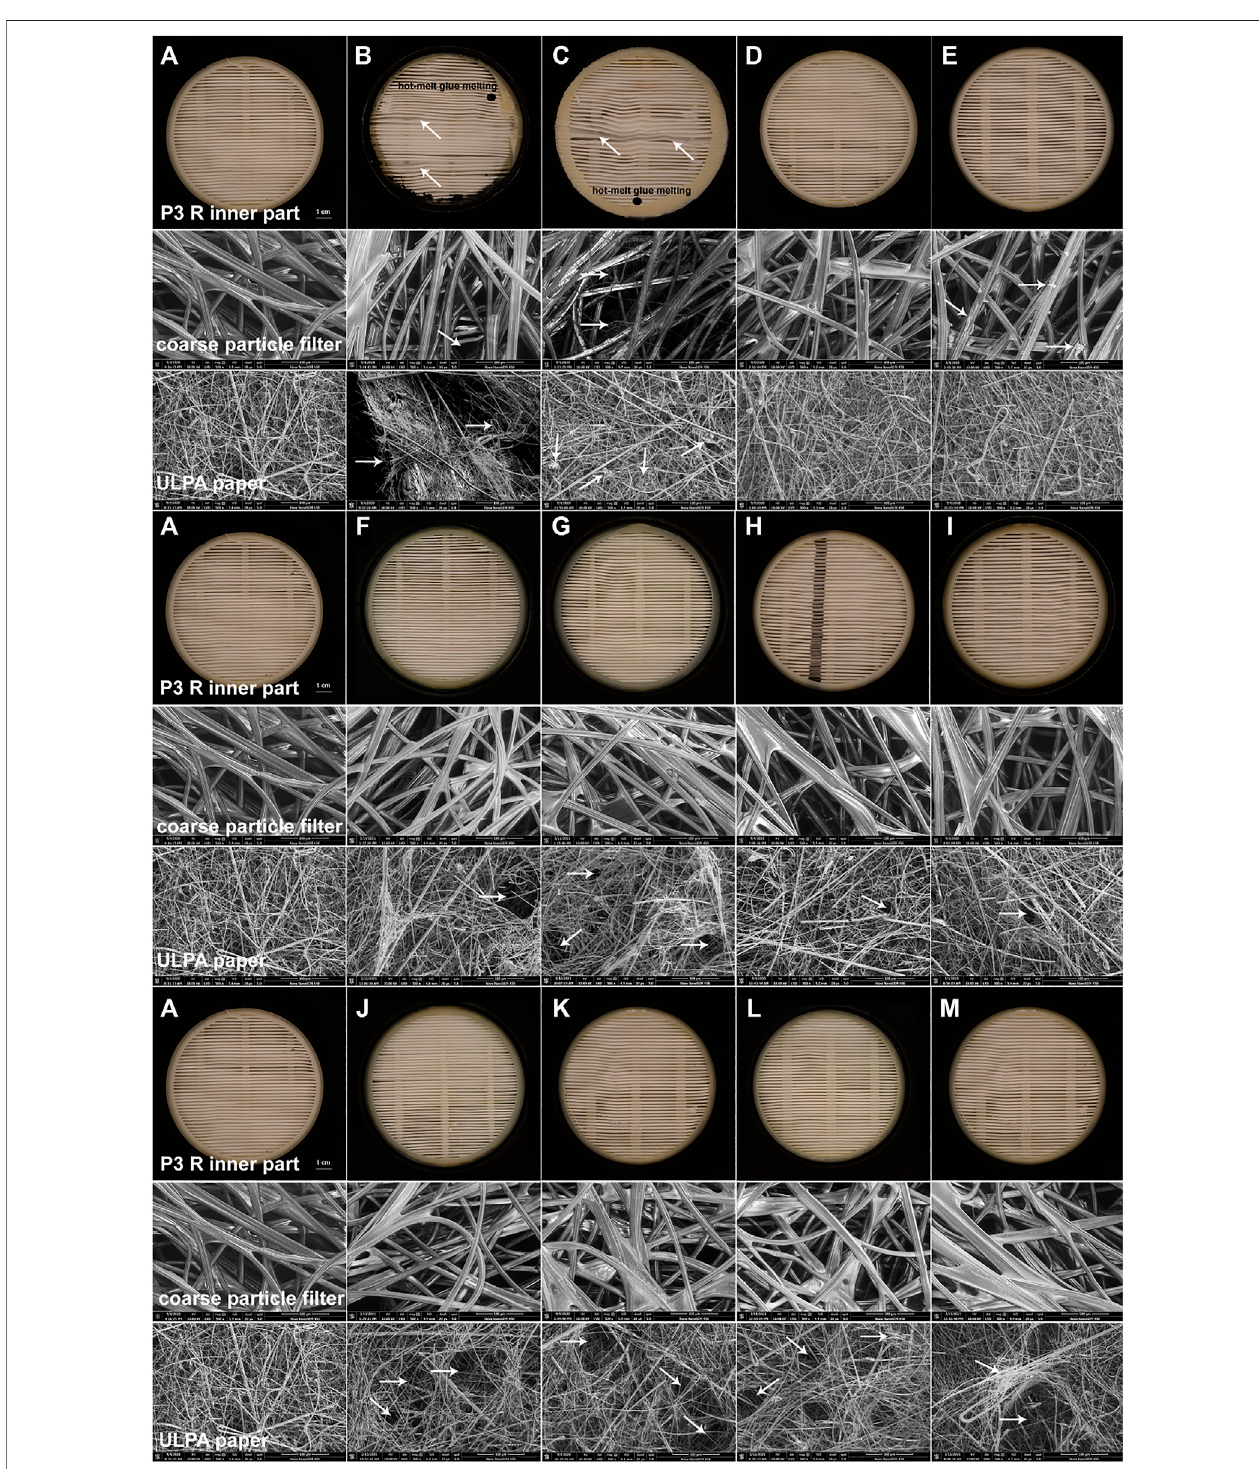
FIGURE4| SEMimagesofdamagedetectedin fi lterinsertsofP3Rexposedtoselectdisinfectionmethods.ThecompleteP3R fi lterinacartridgewasexposedto thedecontaminationtechniquesspeci fi edintheMethodssectionandphotographed (innerpart)orimagedusingSEMat×500magni fi cation(coarseparticle fi lter,ULPA paper), focusing on the damaged areas typical for individual methods. The following conditions were investigated: (A) untreated control, (B) autoclaving at 121 ° C for 20 min, (C) boiling in tap water for 2 h, (D) soaking in ethanol for 24 h, (E) peracetic acid vapors (Persteril) for 24 h, (F) gamma irradiation for 15 min, (G) UVC irradiationfor24 h, (H) airplasmafor24 h, (I) oxygenplasmafor24 h, (J) dryheatat65 ° Cfor24 h, (K) dryheatat90 ° Cfor24 h, (L) dryheatat95 ° Cfor24 h, (M) dryheat at 100 ° C for 24 h. While most methods caused no or very limited damage, autoclaving and boiling clearly destroyed the fi lter, as documented by all testing approaches applied. Peracetic acid vapors formed a precipitate within coarse particle fi lters. The ULPA paper revealed small holes upon gamma irradiation, UVC or NTP treatments, and was substantially damaged upon all thermal treatments. White arrows indicate the damaged areas and black ellipses show places with hot-melt glue melting. Frontiers in Bioengineering and Biotechnology |